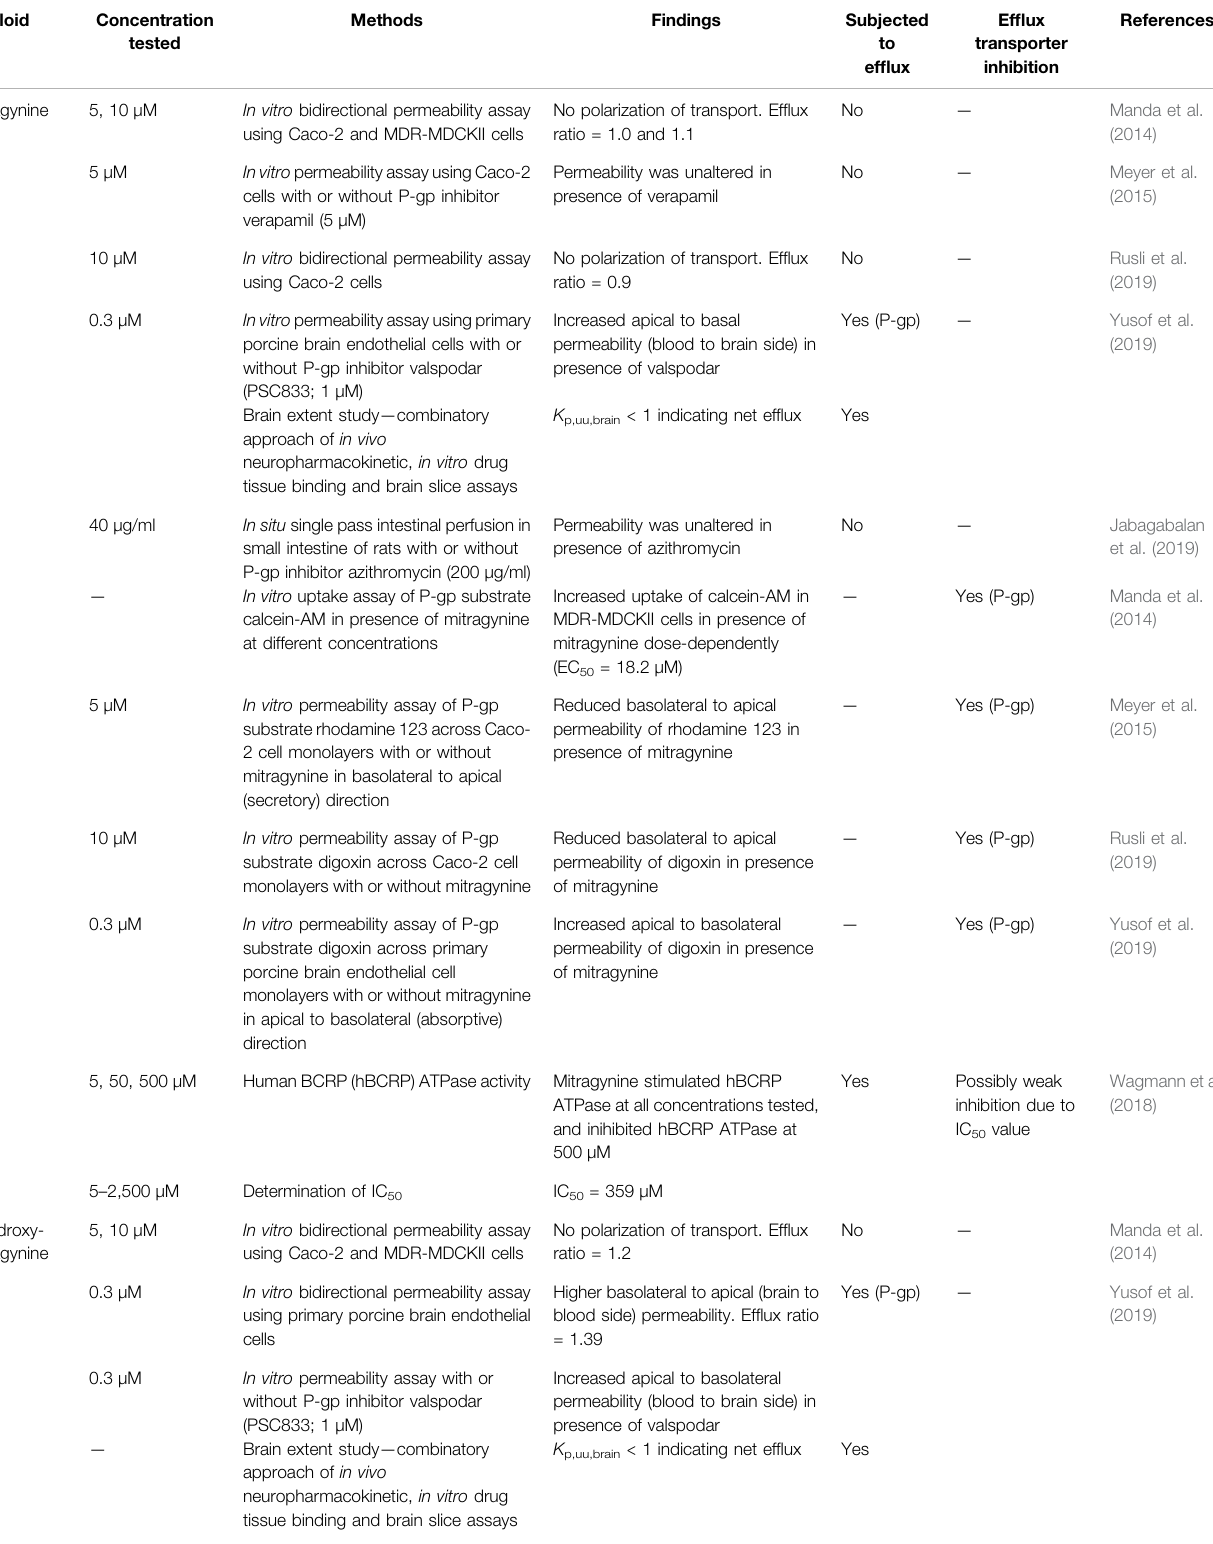
TABLE 4 | Functional interactions of kratom alkaloids with ef fl ux transporters.